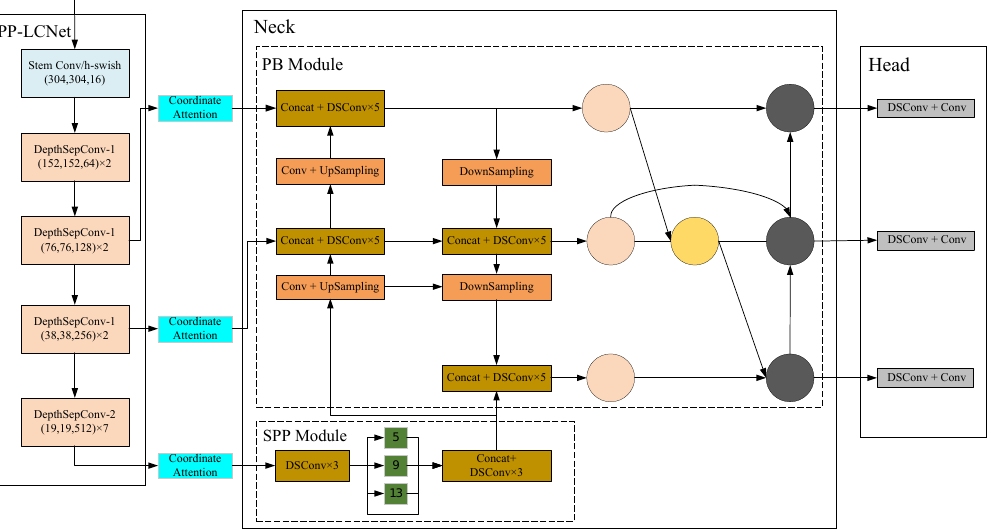
Figure 1. The architecture of the improved YOLOv4. DSConv represents the deepwise separable convolution, which is used in our method to replace the general convolution to decrease the network